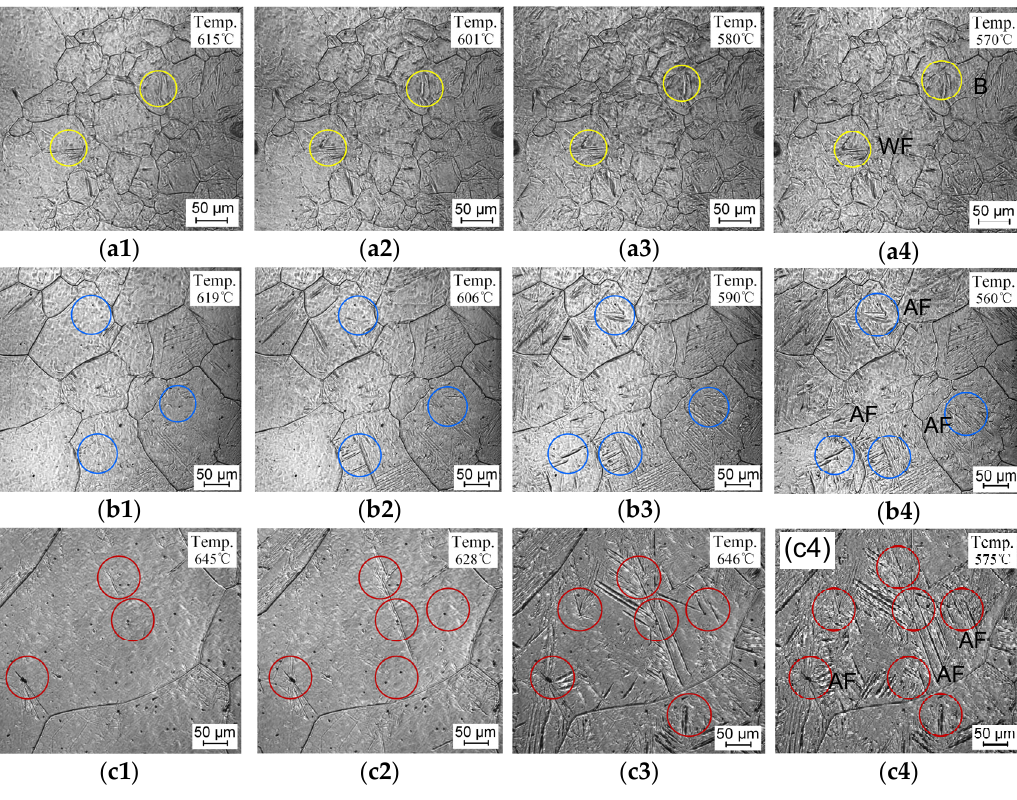
Figure 5. In situ micrographs by laser scanning confocal microscopy (LSCM) during cooling with